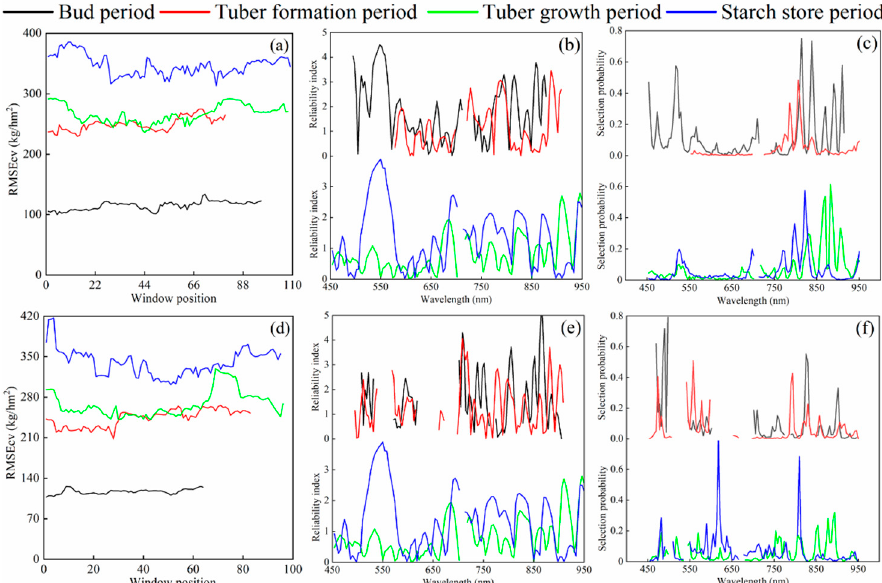
Figure 5. Determination of the influential spectra features in the AGB estimation of potatoes based on the CRS and FDS at the bud period, tuber-formation period, tuber-growth period, starch-storage period. ( a , d ) Cross-validation RMSEcv statistics using MWPLS based on CRS and FDS, respectively. ( b , e ) Reliability index statistics using MC-UVE based on CRS and FDS, respectively. ( c , f ) Selection probability statistics using RF based on CRS and FDS, respectively.